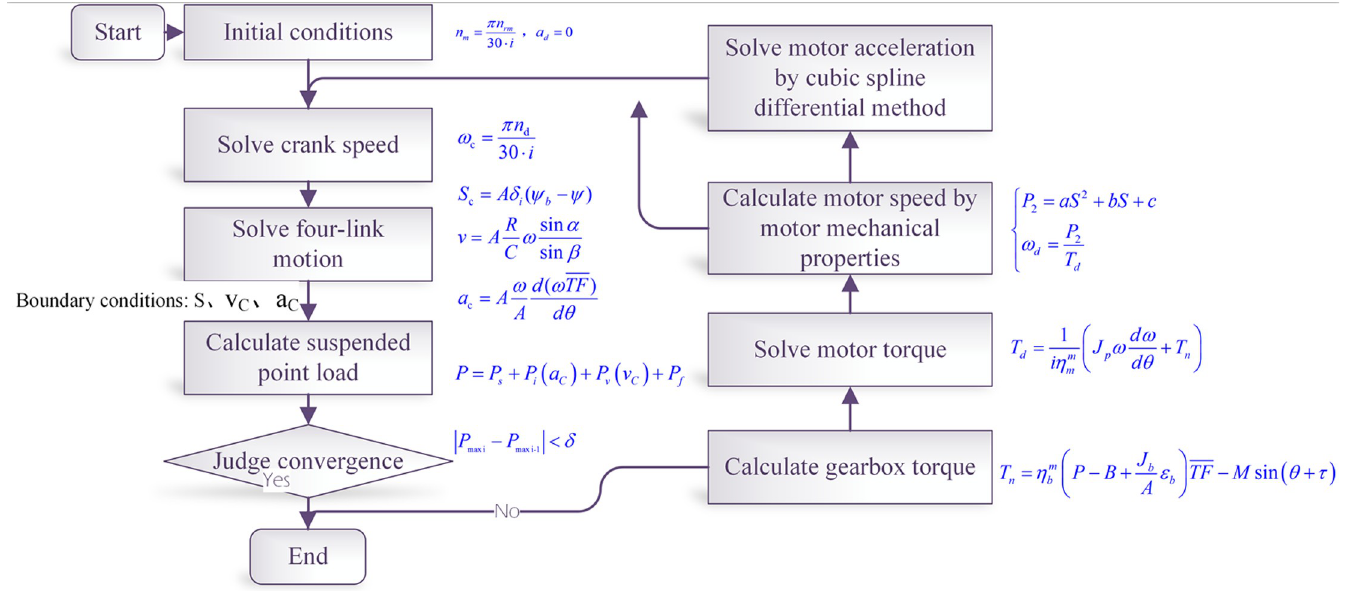
Fig 3. A flow chart for calculation procedures of the solution method.